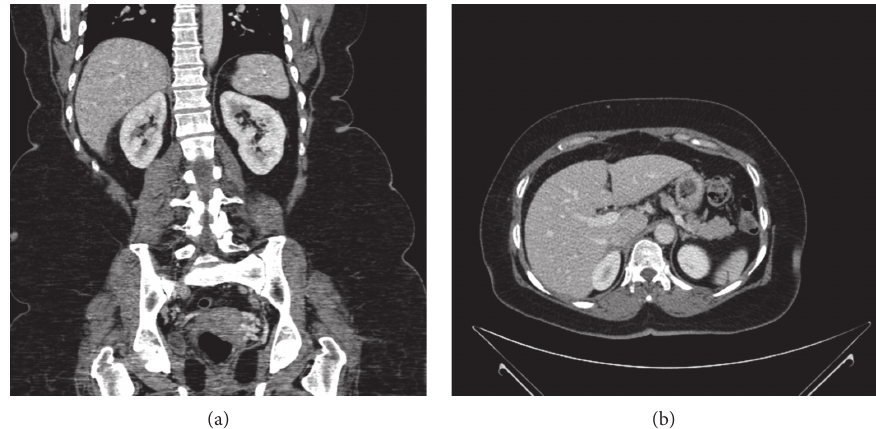
Figure 6: Postop CT adrenal: (a) coronal section and (b) axial section showed postresection of the right adrenal mass with no signs of residual or recurrent disease. The left adrenal gland is